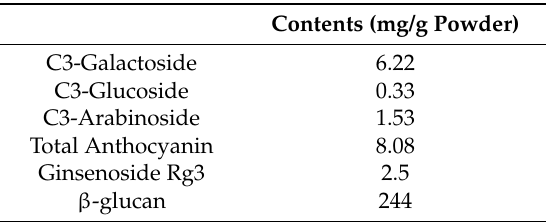
Table 1. The contents of ingredients in the mixture.